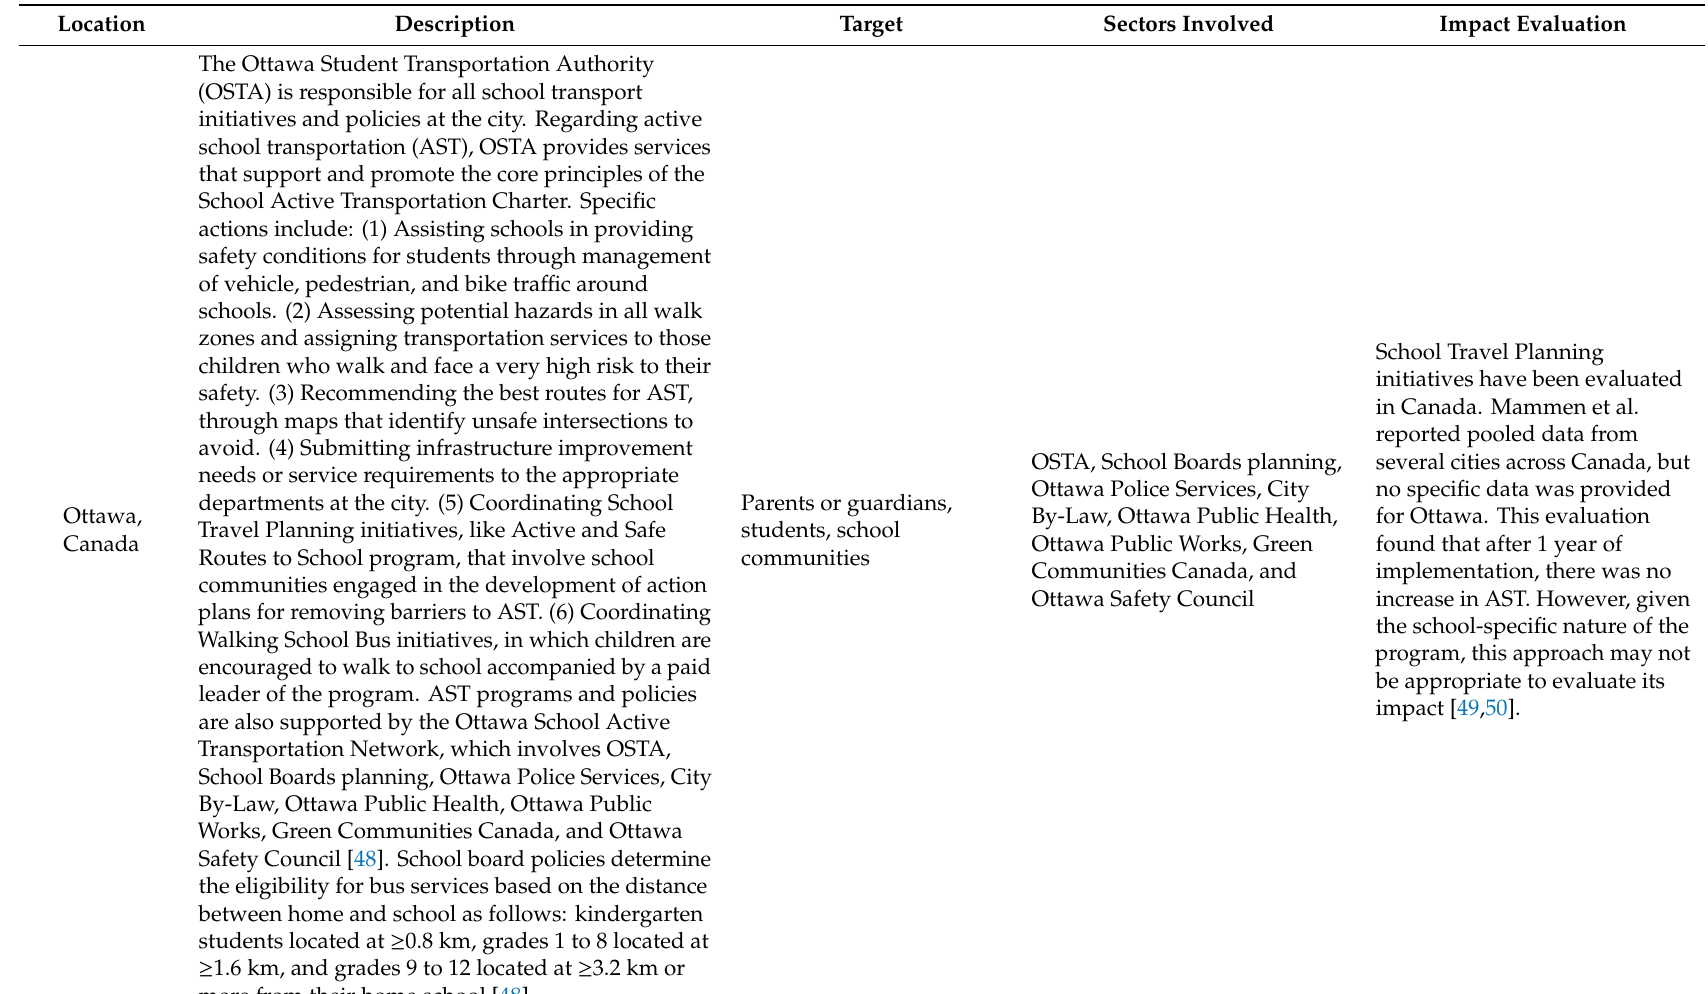
Table 4. Description of policies that support active school transport in Ottawa, Bogota, Helsinki, Cape Town, and Baton Rouge.